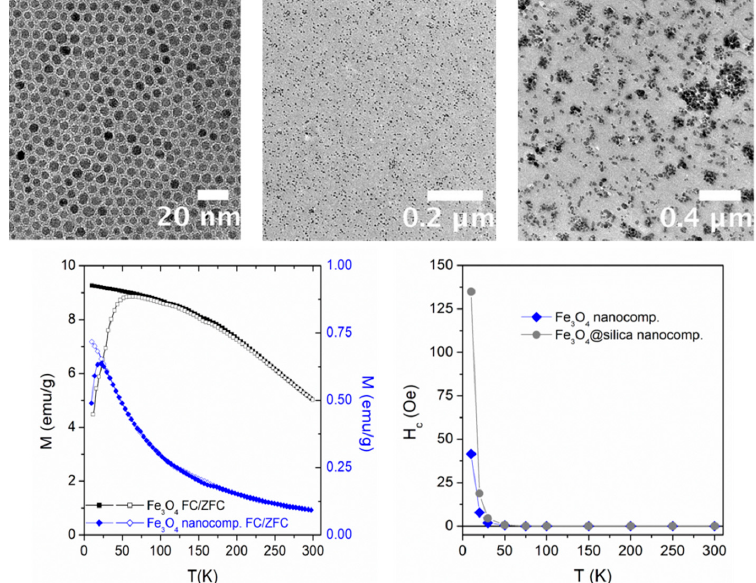
Figure 1. ( Top left ) transmission electron microscopy (TEM) image of bare magnetite nanoparticles (NPs) characterized by a narrow size distribution. Reprinted from the work of [11] with permission from Elsevier; ( top center ) TEM image of a magnetic nanocomposite (NC) obtained from the bare NPs shown in Figure 1. Reprinted from the work of [11] with permission from Elsevier; ( top right ) TEM image of a polymer NC containing Fe 3 O 4 @silica NPs. Reprinted from the work of [11] with permission from Elsevier; ( bottom left ) field-cooled (FC)/zero-field-cooled (ZFC) curves measured from T = 10 K to T = 300 K in an almost monodisperse magnetite nanopowder ( top left ) and in the corresponding NC ( top center ); ( bottom right ) temperature behavior of the coercive field of NCs containing bare magnetite NPs and Fe 3 O 4 @silica